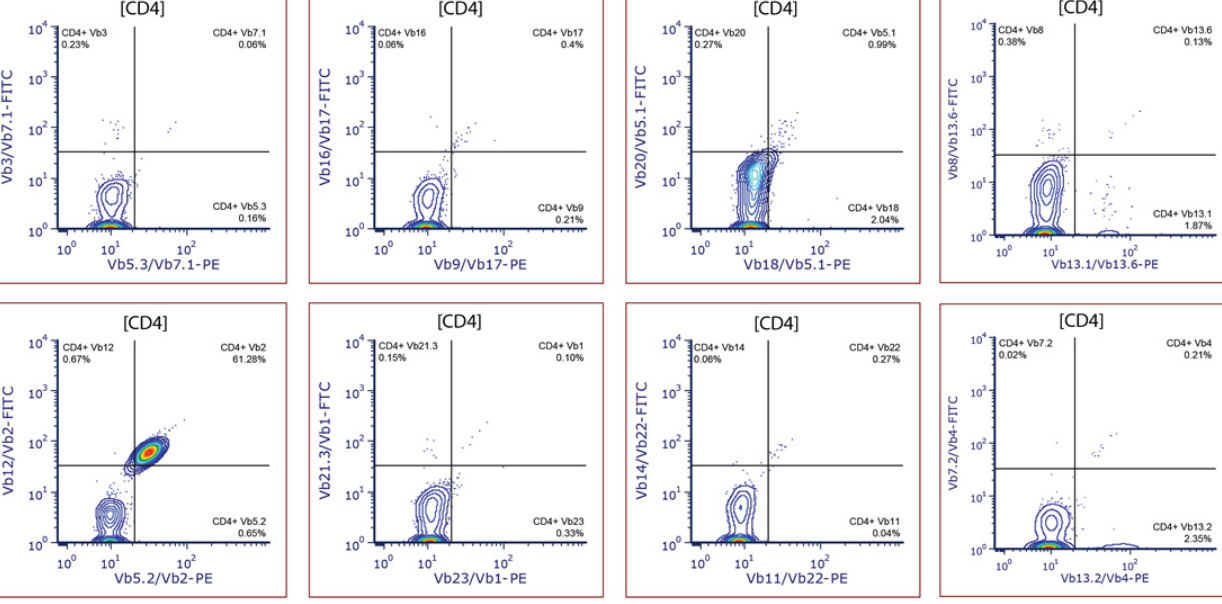
Figure A3. Example of TCR Vbeta clonal detection (Vbeta 2) in the blood of a CTCL patient. Blood cells from the CTCL patient presented in Figure 3 were stained using monoclonal antibodies specific for different V-beta chains. The data indicate that in this patient, the tumour expressed V-beta-2.